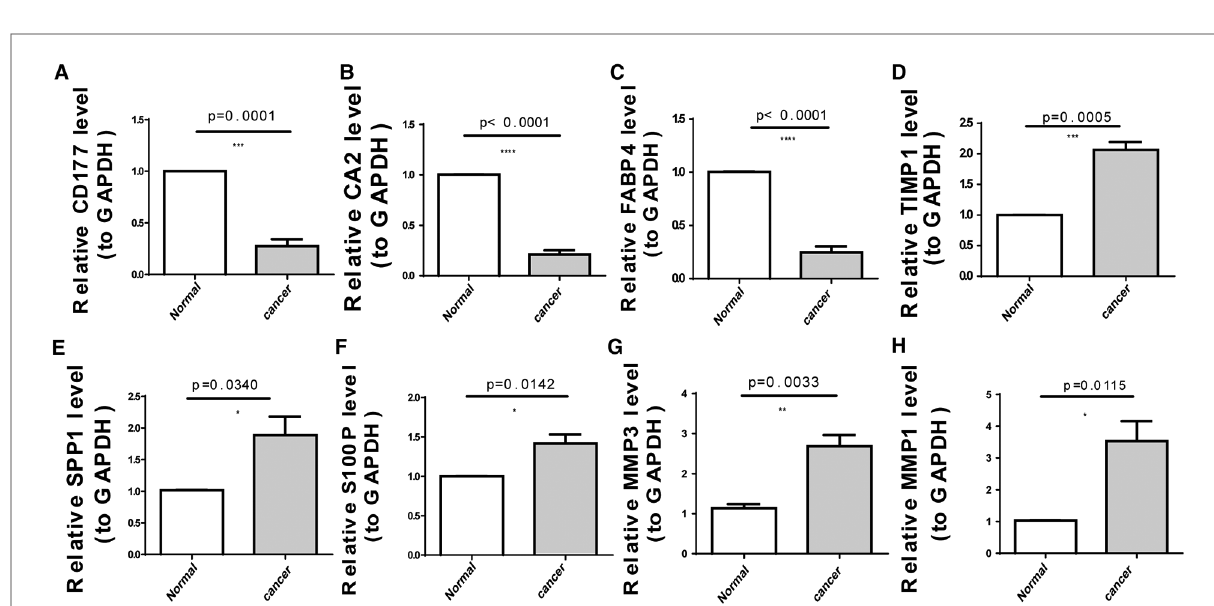
FIGURE 10 Expression levels of eight UC-related prognostic genes in clinical tissues determined using quantitative reverse transcription-polymerase chain reaction (qRT-PCR). ( A ) CD177 ( B ) carbonic anhydrase 2 ( CA2 ), ( C ) fatty acid-binding protein 4 ( FABP4 ), ( D ) tissue inhibitor of metalloproteinase-1 ( TIMP1 ), ( E ) secreted phosphoprotein 1 ( SPP1 ), ( F ) S100 calcium-binding protein P ( S100P ), ( G ) matrix metallopeptidase ( MMP )- 3 , and ( H ) MMP1 . * p <0.05, ** p <0.01, *** p <0.001, **** p